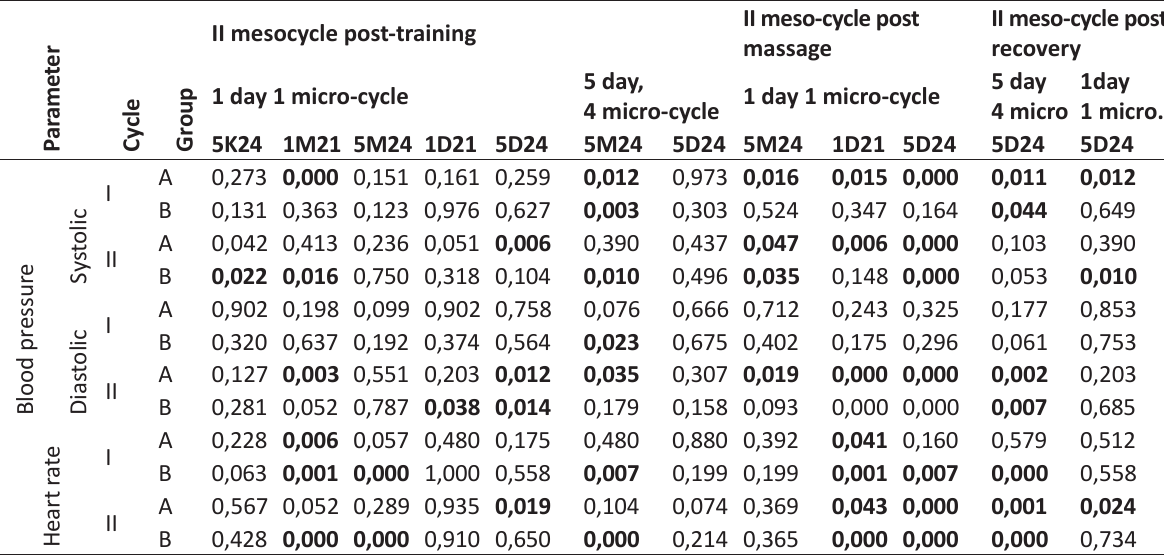
Table 3. Evaluation of means of blood pressure and heart rate in selected days of training during Cycle I and II – second meso-cycle pre-training measurements – variance analysis and